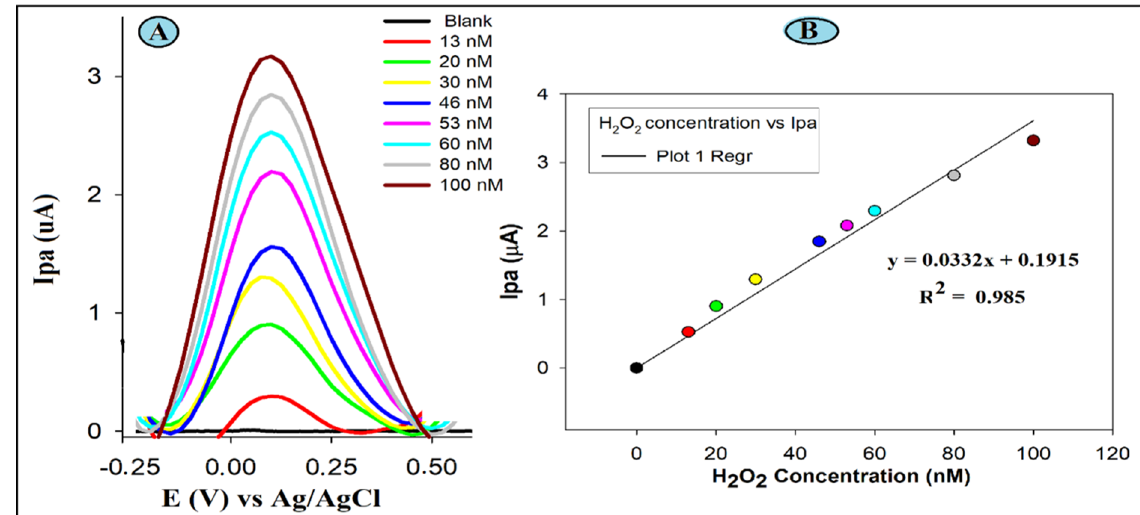
Figure 4. DPV ( A ) experiments of H 2 O 2 in 0.1 M PB solution (pH 5.5); the linear relationship of the currents vs. the concentrations ( B ) for the GCE/SiO-CeONCs sensor. Scan rate, 0.03 V/s; Epulse, 50 mV; tpulse, 30 ms.